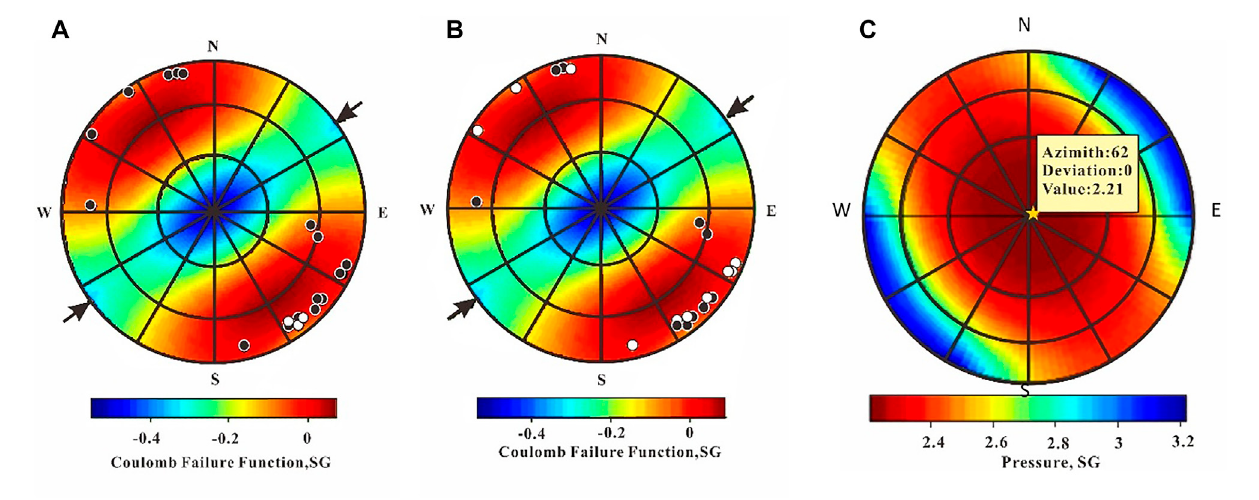
FIGURE 6 | Modeling results showing the critical fracture opening pressure in Well L1. This fi gure is called stereographic (Zoback 2007). The opening pressure of reservoir Section 2 and reservoir Section 3 is simulated together. When the injection pressure is simulated to 1.61 sg, the natural fractures of the fi rst section are activated (A) . When the injection pressure issimulated to1.82 sg, thenatural fractures ofthe second section areactivated (B) , indicating thatthe natural fractures ofthe fi rst section ofthe reservoir are easier tobe stimulated, and the potential mechanical activity is better. There are no natural fractures in the third section in which the critical opening pressure of the matrix reservoir is simulated (C) . The results are shown in Table 1 .